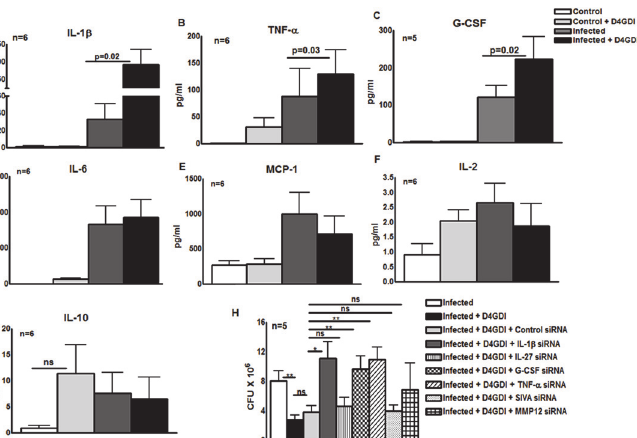
Figure 6. IL-1 β and TNF- α contribute to D4GDI-dependent inhibition of M. tb growth. MDMs from 5 to 6 healthy donors with LTBI were infected with H37Rv, and control and infected MDMs were cultured with or without recombinant D4GDI. After 6 hr, culture supernatants were collected and levels of 27 different cytokines and chemokines were measured by multiplex ELISA. (A) IL-1 β production. (B) TNF- α production. (C) G-CSF production. (D) IL-6 production. (E) MCP-1 production. (F) IL-2production. (G) IL-10 production. (H) Effect of IL-1 β , IL-27, G-CSF, TNF- α , SIVA and MMP12 siRNAs on D4GDI-dependent M. tb growth inhibition. MDMs from 5 donors were transfected with siRNA for IL-1 β , IL-27, G-CSF, TNF- α , SIVA, MMP-12 or scrambled siRNA (control siRNA), and infected with H37Rv at a MOI of 1:2.5 (2.5 M. tb to one MDM). Some infected MDMs were cultured with recombinant D4GDI (10 ng/ml). After 7 days, CFU were measured. Mean values, p values and SEs are shown. * p < 0.05, ** p <